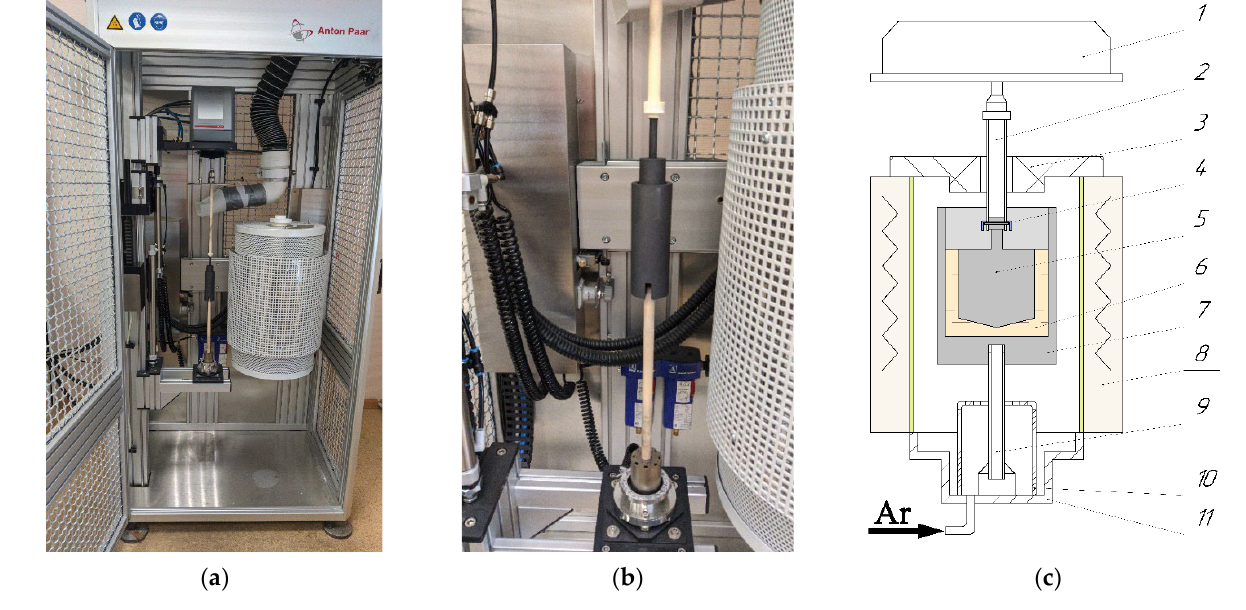
Figure 1. Exterior of rheometer FRS-1600 ( a ). Illustration of outer and inner cylinders ( b ) and scheme of the rheometer ( c ): 1—measuring head; 2—upper ceramic rod for fixing the rotor; 3—heat insulator cover; 4—system for attaching the rotor to the upper rod (pin + restrictive ring); 5—rotor (inner cylinder); 6—melt; 7—crucible (outer cylinder); 8—resistance shaft furnace with vertically arranged SiC heaters; 9—lower ceramic rod for mounting the crucible; 10—gas divider; 11—bottom cover with heat-insulating inserts.